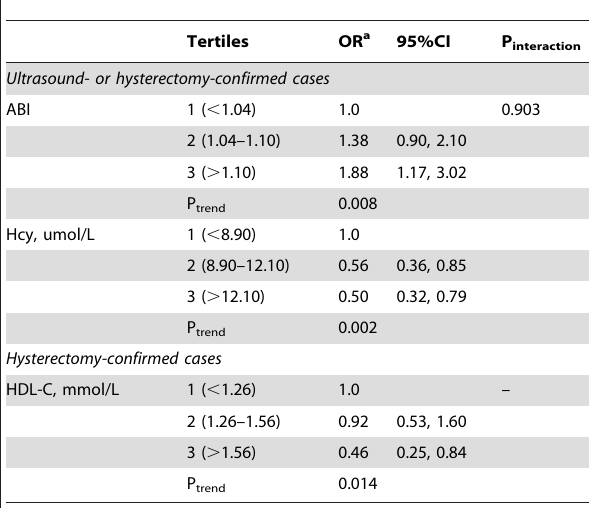
Table 4. Multivariable model of best predictors according to subclinical atherogenic and cardiovascular risk parameters for UF in the overall and hysterectomy-confirmed